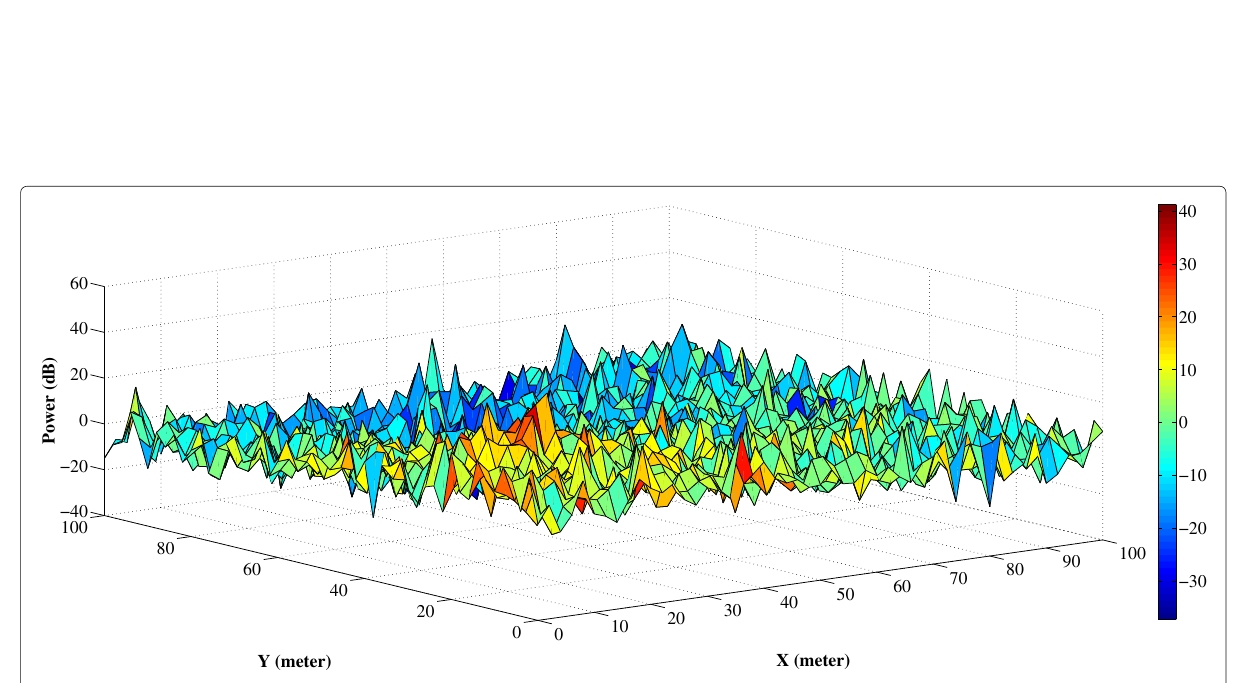
Fig. 3 RSSD distribution of AP12 without filtering. P ( d 0 ) = 10 dB, α = 1.8, d = 2 m, and σ = 5.2